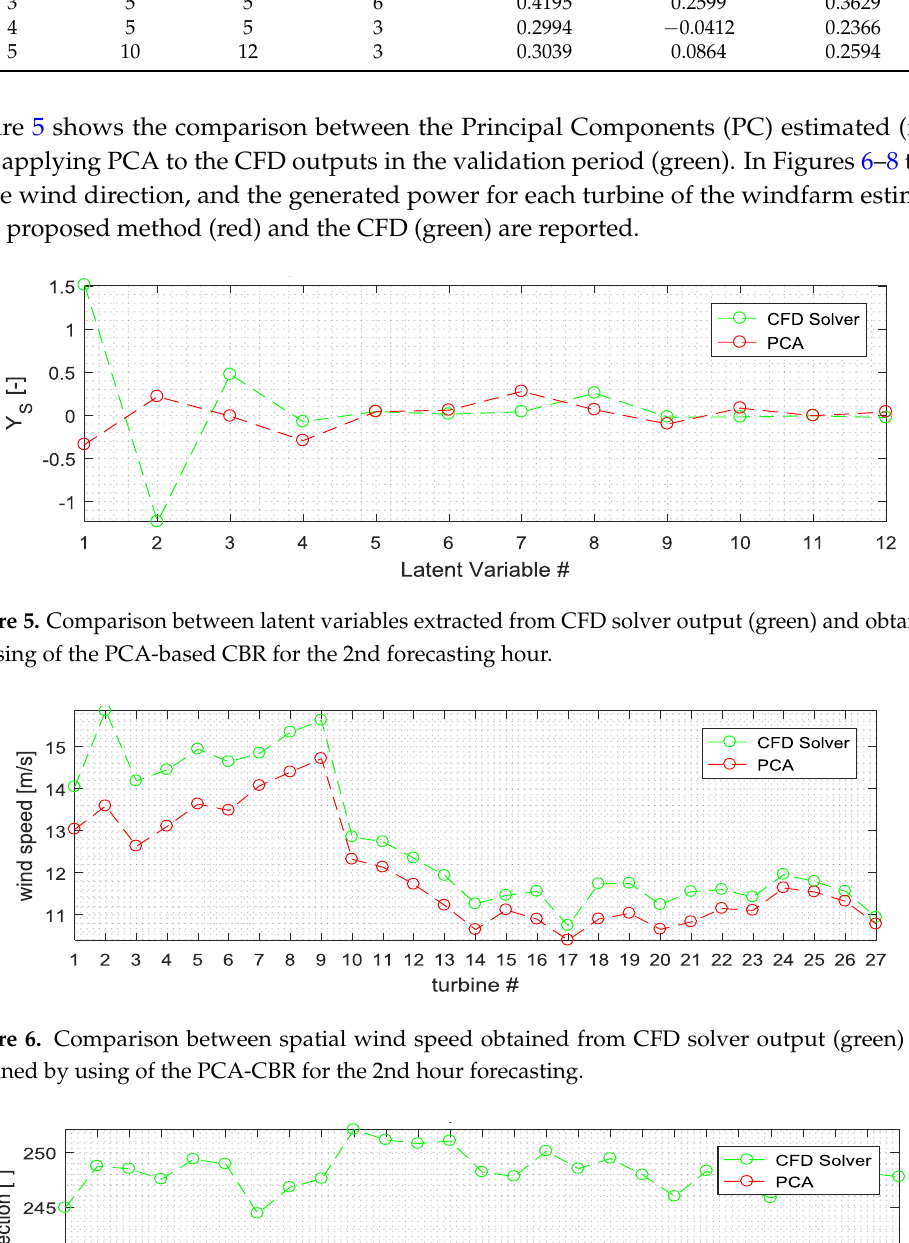
Figure 7. Comparison between spatial power output obtained from CFD solver output (green) and obtained by using of PCA for the 2nd forecasting hour.